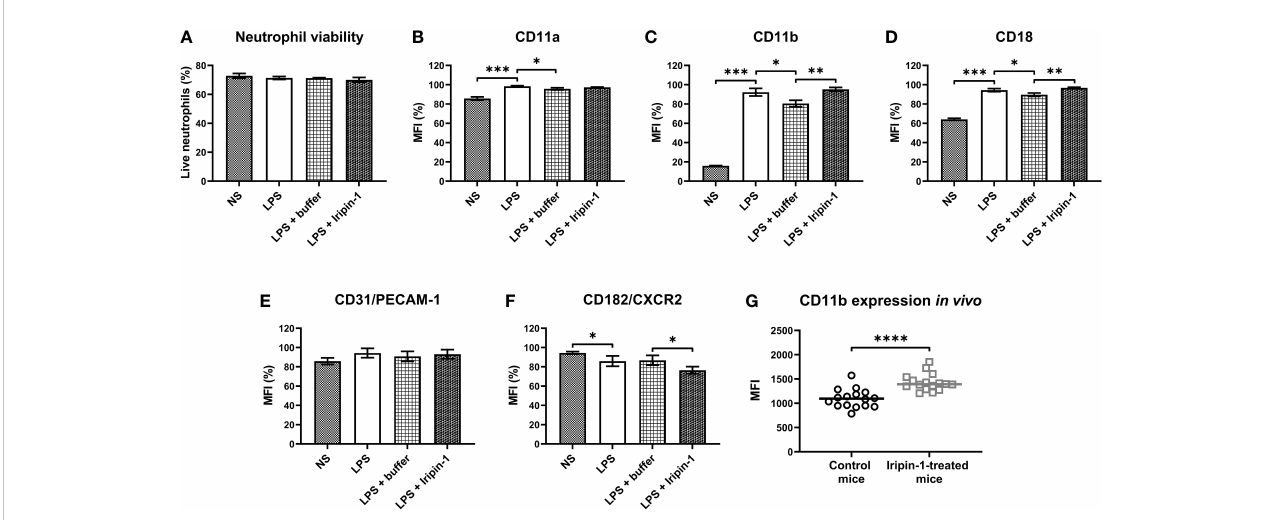
FIGURE 8 Iripin-1 potentiates the expression of Mac-1 (CD11b/CD18) and reduces the expression of CXCR2 on the neutrophil surface. (A-F) Neutrophils obtained by magnetic-activated cell sorting of bone marrow cells were cultured in the presence of LPS (1 m g/mL), control buffer, and Iripin-1 (2 m M) for 3 h and subsequently the cell viability (A) and expression levels of CD11a (B) , CD11b (C) , CD18 (D) , PECAM-1 (E) , and CXCR2 (F) were determined using multi- color fl ow cytometry. Data in the graphs are expressed as mean values of three repetitions of the experiment ± SEM. The graph in (A) shows the percentage of viable neutrophils among single cells. The median fl uorescence intensity (MFI) values in (B – F) are expressed as a percentage of the highest MFI value (which was set to 100%) measured in each repetition of the experiment. Statistically signi fi cant differences between the groups NS and LPS, LPS and LPS + buffer, LPS + buffer and LPS + Iripin-1 are marked with asterisks (*p < 0.05, **p < 0.01, ***p < 0.001). NS, unstimulated cells. (G) Mice were injected ip with Iripin-1 (2 mg/kg) or the corresponding amount of control buffer, and peritonitis was induced with ip injection of 200 m L 3% TGM. Cells obtained by peritoneal lavage 4 h after TGM administration were analyzed on a fl ow cytometer to determine the expression level of CD11b on the neutrophil surface. Each control mouse is represented by one black-lined circle, and each Iripin-1-treated mouse is represented by one grey-lined square. The black and grey horizontal lines mark the median values. Asterisks indicate statistically signi fi cant difference between the two groups (****p < 0.0001). MFI, median fl uorescence intensity.